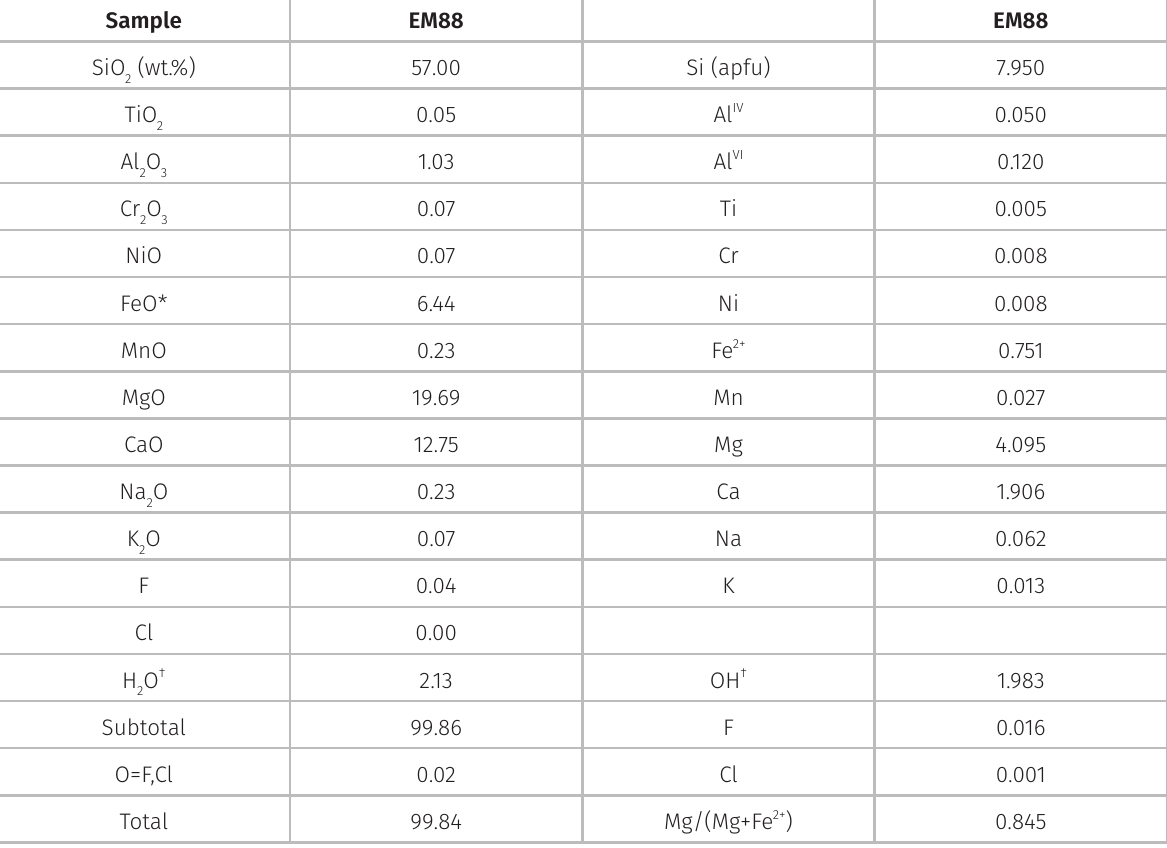
Table IV. EPMA average chemical composition for amphibole of Paraná emerald deposit. Sample